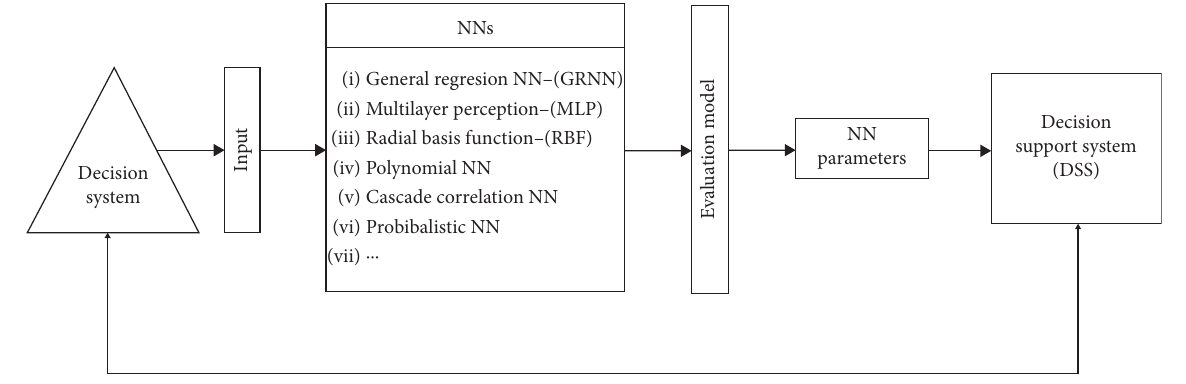
Figure 2: NNs as part of